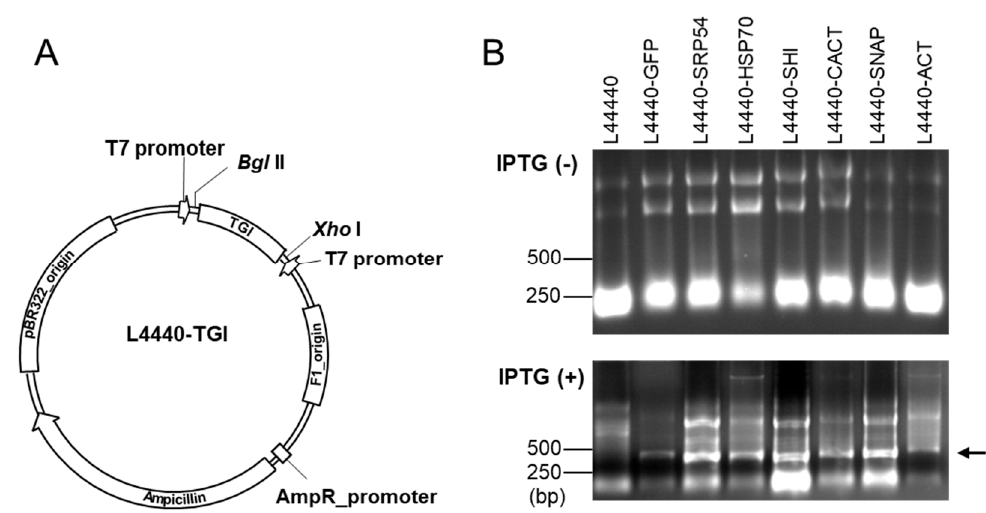
Figure 1. Schematic diagram of the E. coli- expressed dsRNA production system. ( A ) The target gene of interest (TGI) was inserted into the expression vector (L4440) through homologous recombination [32,33]. ( B ) Production of dsRNA with an inducer, IPTG. Transformed E. coli with L4440-TGI expressed dsRNA in the presence of IPTG. Arrow indicates the dsRNA production upon IPTG induction.